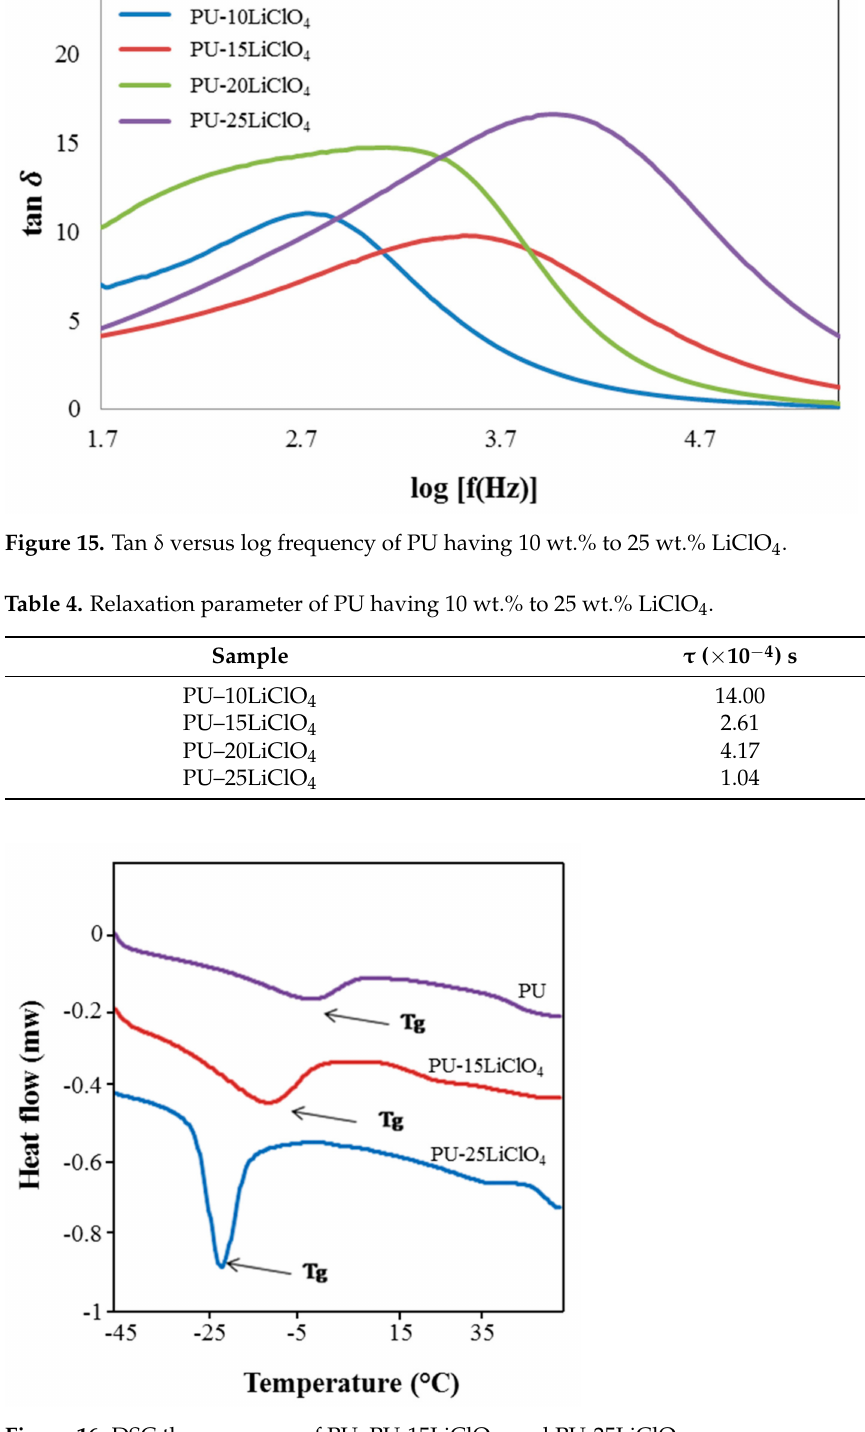
Figure 16. DSC thermograms of PU, PU-15LiClO 4 , and PU-25LiClO 4